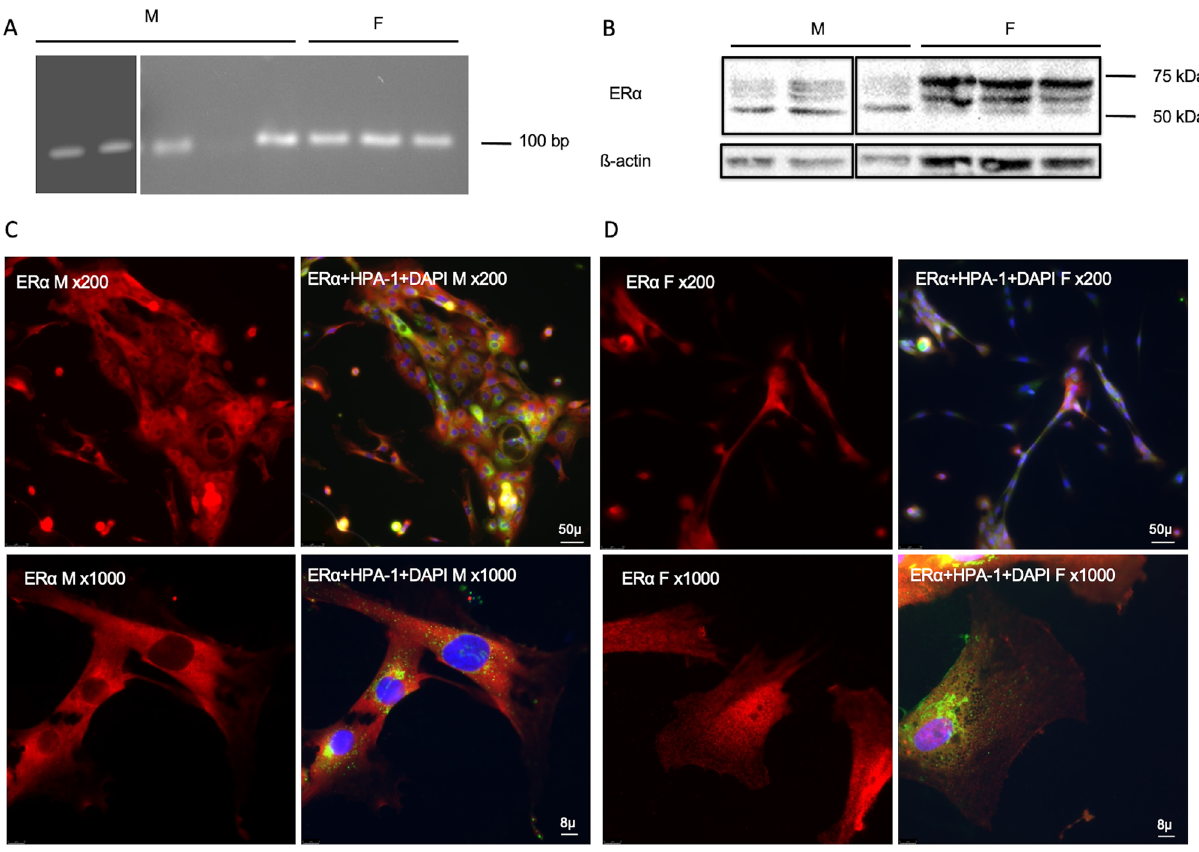
Figure 1. Identification of ERα in human conjunctival goblet cells cultured from males and females. RNA was isolated from cultured goblet cells and RT-PCR performed using primers for human Erα . A single band was detected at around 100 bp in samples from 4 out of 5 male (M) and 3 out of 3 females (F) ( A ). Protein samples were collected from cell pellets and Western Blot analysis was performed using antibody against ERα. A major band at 50 kDa was detected in males, while a major band at 75 kDa and a minor band between 75 and 50 kDa were detected in females ( B ). Immunofluorescence microscopy was performed on cultured goblet cells using antibodies to ERα ( C and D ). ( C ) indicate immunofluorescence to ERα (red) in male cells; ( D ) indicate immunofluorescence to ERα (red) in female cells; an overlay of anti-ERα, HPA-1 (green, indicates the secretory granules of goblet cells), and DAPI (blue, indicates cell nuclei) is shown next to the single channel image of ERα. Magnification was × 200 in the upper panels; × 1000 in the lower panels. Full gels and blots are included in “Supplementary information”. Original blots/gels are presented in Supplementary Figs. 5 and